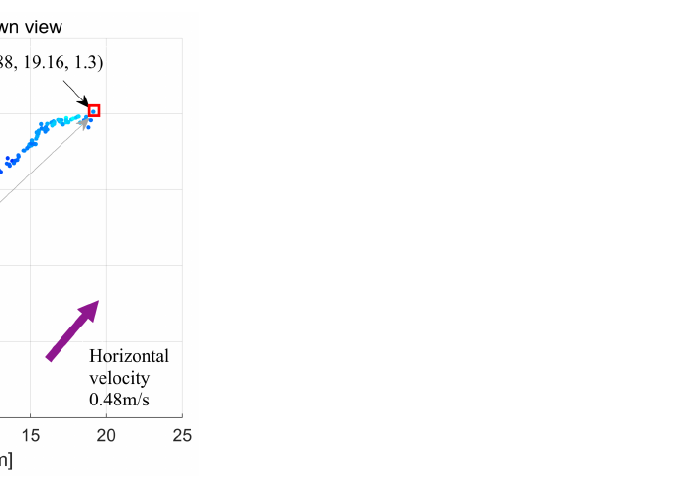
Figure 13. A top-down view of the gas leakage spine illustrating the current effect on the horizontal displacement (23.29 m) of bubbles. The average horizontal velocity of the current was measured by the DVL to be approximately 0.48 m/s.